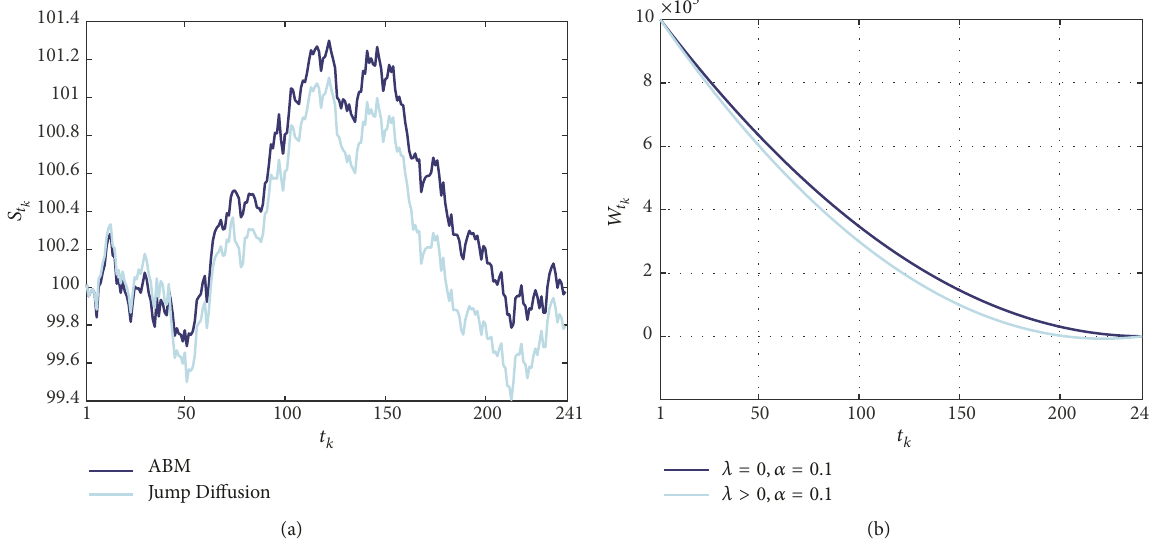
Figure 2: The execution trajectories under different price